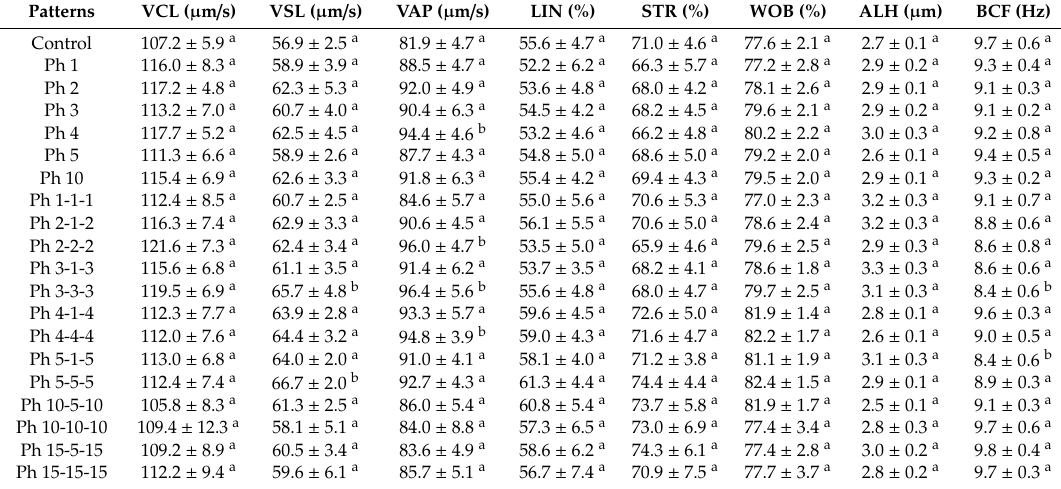
Figure 4. Percentages of total ( a ; TMOT) and progressively motile spermatozoa ( b ; PMOT) in the control and different irradiation patterns. No significant differences between the control and light-stimulation patterns were observed. Data are shown as mean ± SEM of nine independent experiments. Table 1. Kinetic parameters (mean ± SEM) of horse spermatozoa in the control and different irradiation patterns.